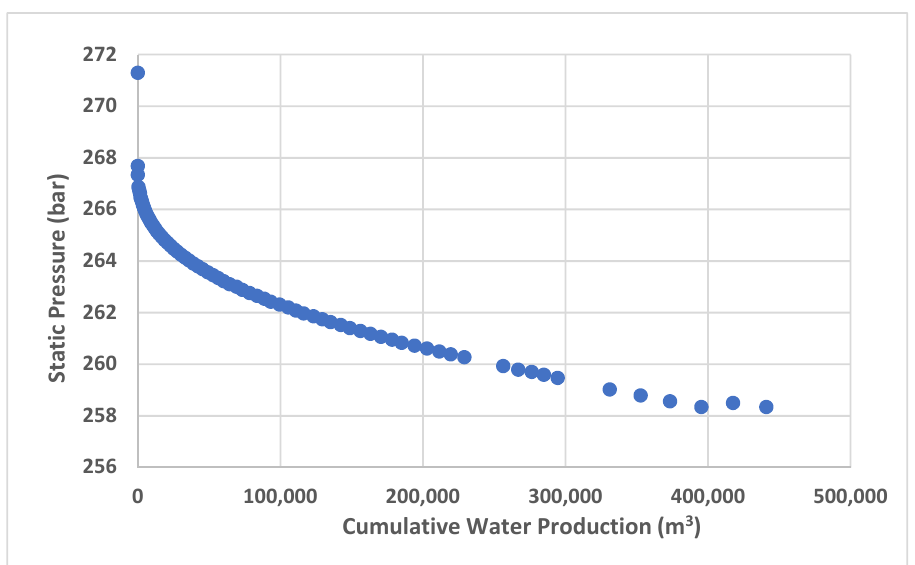
Figure 7. Pressure versus water produced.